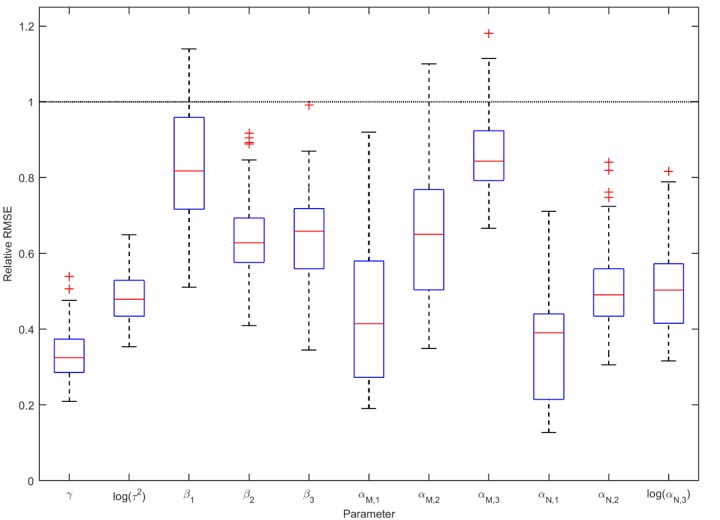
Accuracy of the parameter estimates from the ABC analysis of infections and co-infections.Each boxplot shows the distribution of relative RMSE values for one parameter for year 2012 evaluated over 100 simulated test data sets with known parameter values. Relative RMSE 1 indicates no improvement over the prior distribution, while a value of 0 indicates perfect estimate. The parameter affecting the incidence of coinfections, γ, is among the best-estimated ones.